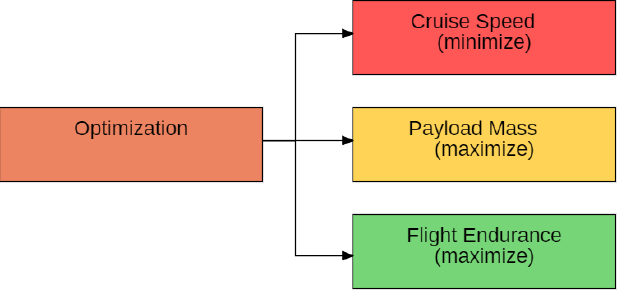
Figure 12. Parameters to be optimized by the algorithm.